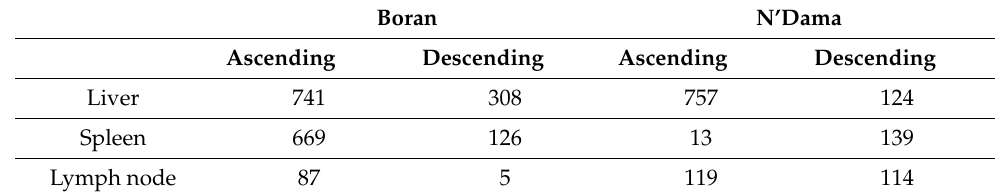
Table 1. Number of MEGs in ascending and descending order for liver-, spleen- and lymph node tissues for the cattle breeds Boran and N’Dama. Boran N’Dama Ascending Descending Ascending Descending Liver